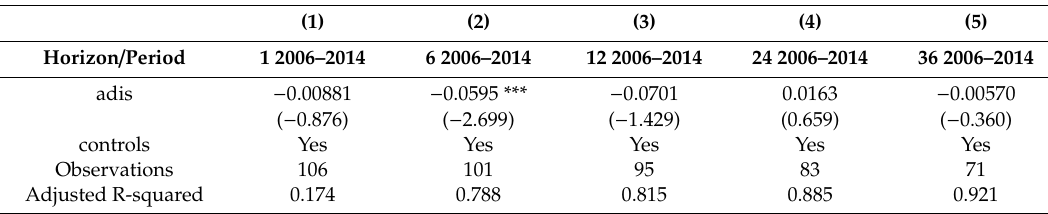
Panel B: The first subperiod, stocks with and without put